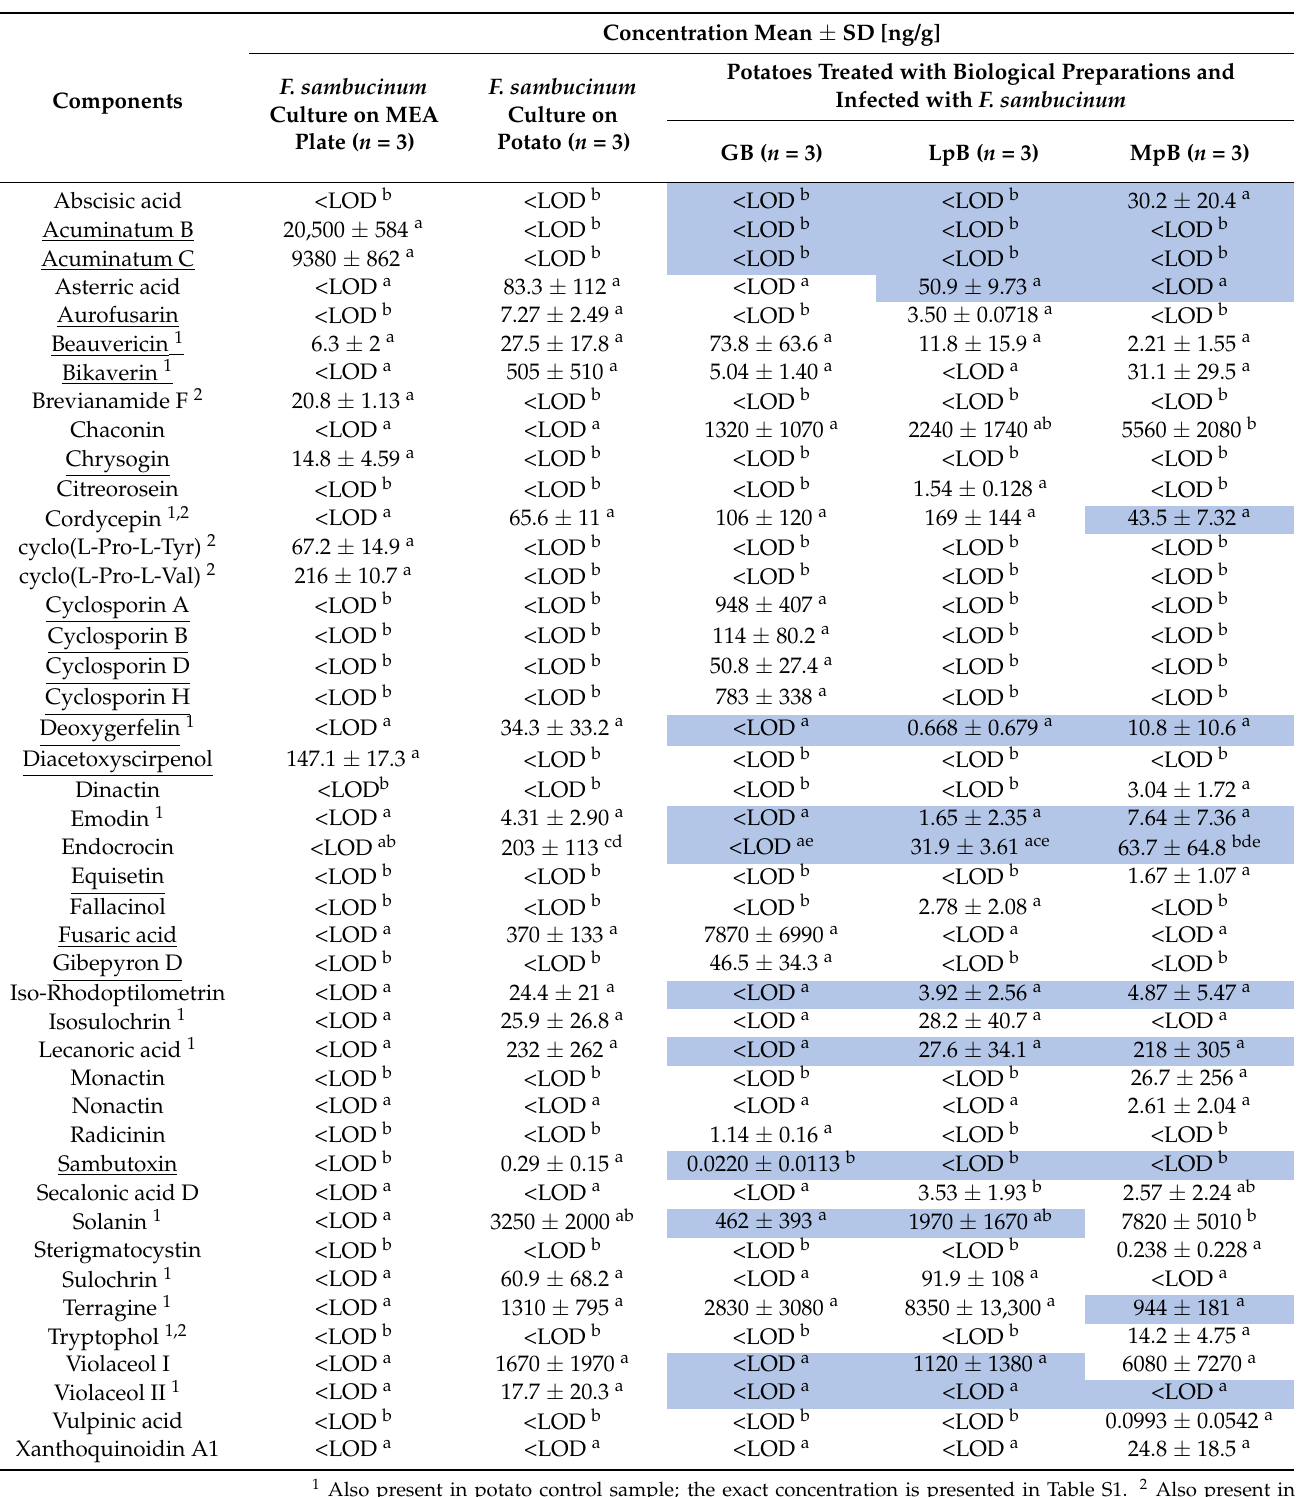
Table 1. Secondary metabolites of Fusarium sambucinum cultured on MEA plates and potatoes treated with